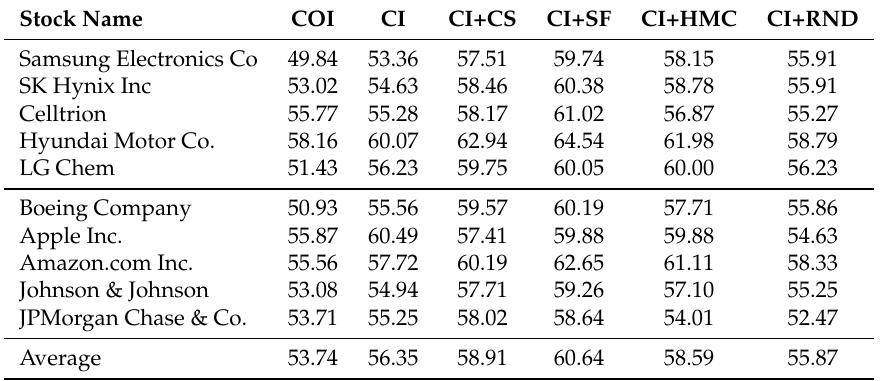
Table 5. Average accuracy of the different types of input variables over all study